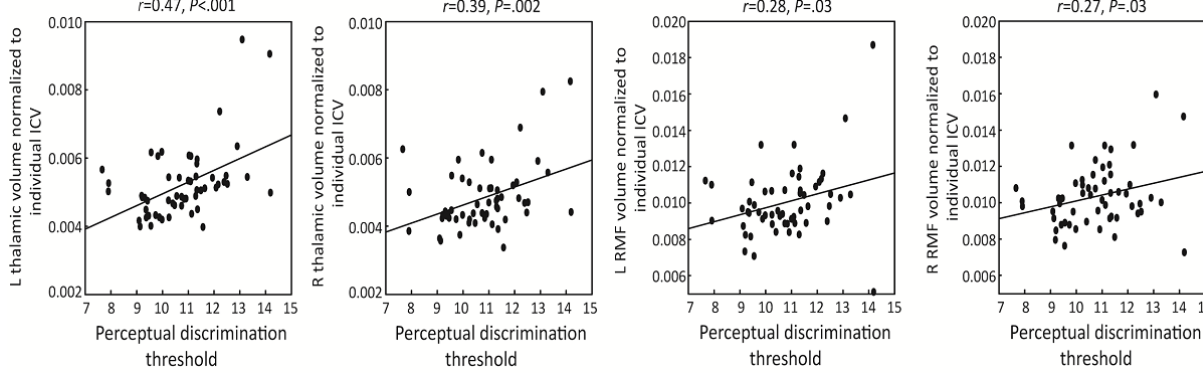
Figure 6. Correlation between EVO Monitor performance and magnetic resonance imaging volumetric data. ICV: intracranial volume; L: left; R: right; RMF: rostral middle